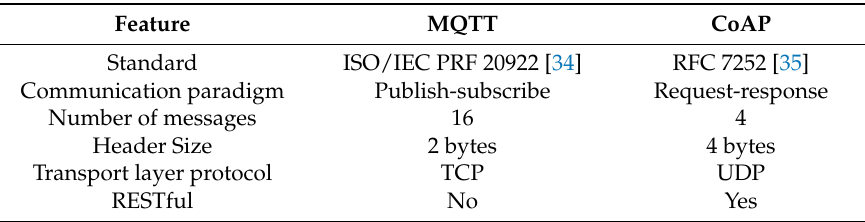
Table 1. Comparison of MQTT and